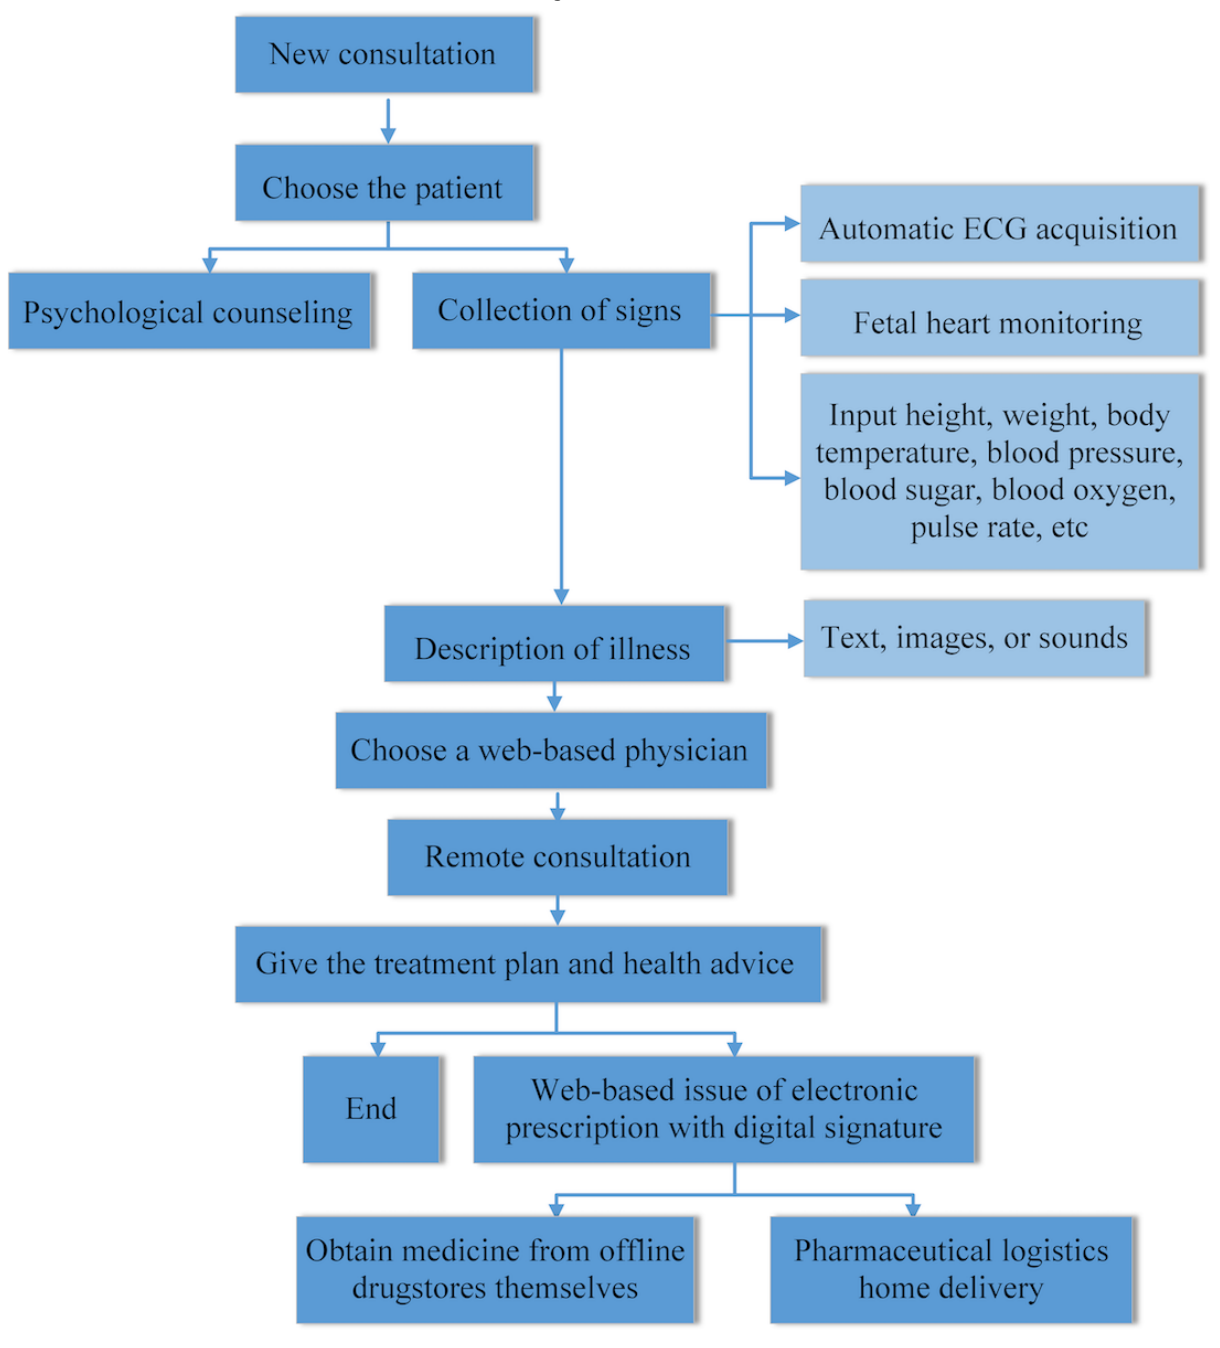
Figure 4. Flowchart of web-based consultation. ECG: